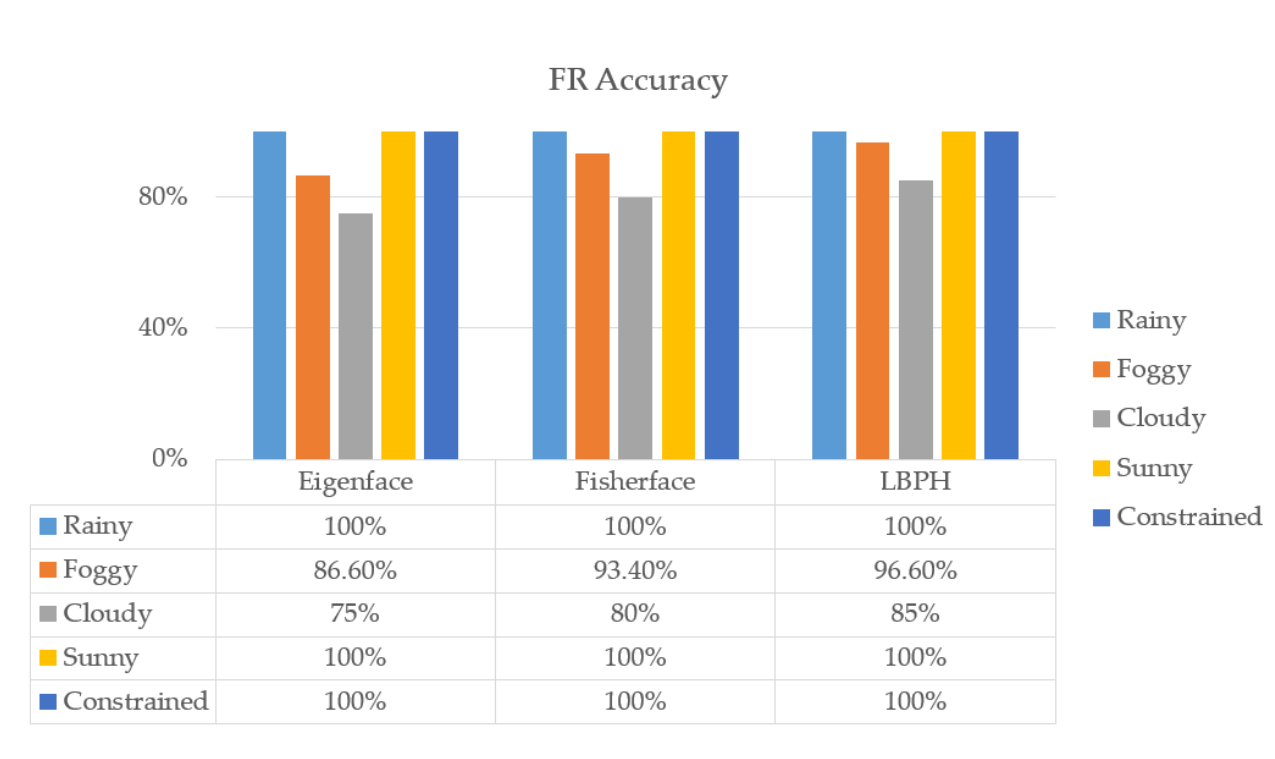
Figure 3. FR algorithm performance in unconstrained